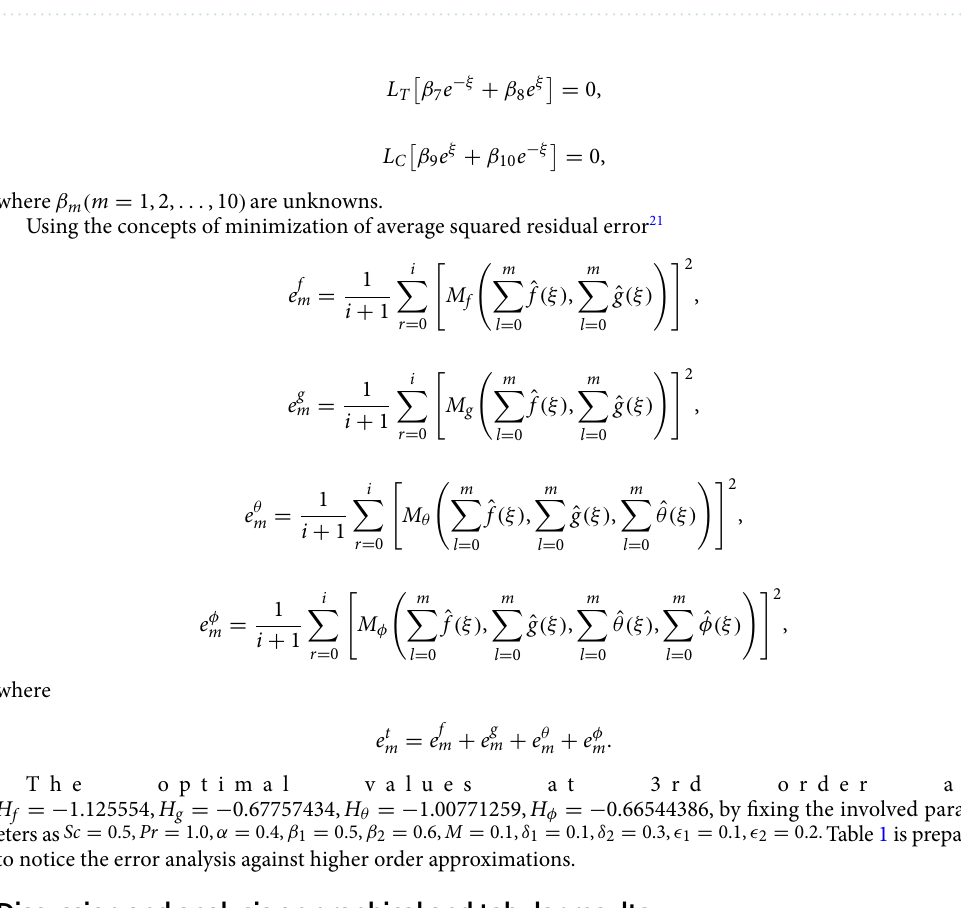
Table 1. Computation of averaged squared residuals errors of velocity, temperature, and concentration solution.